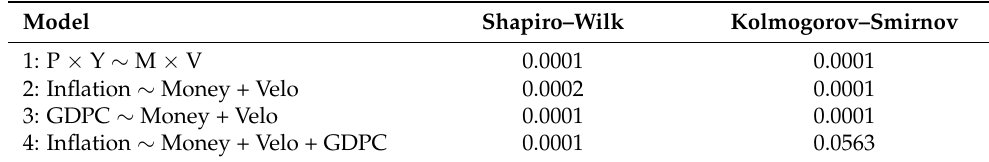
Table 4. Residual normality test, p